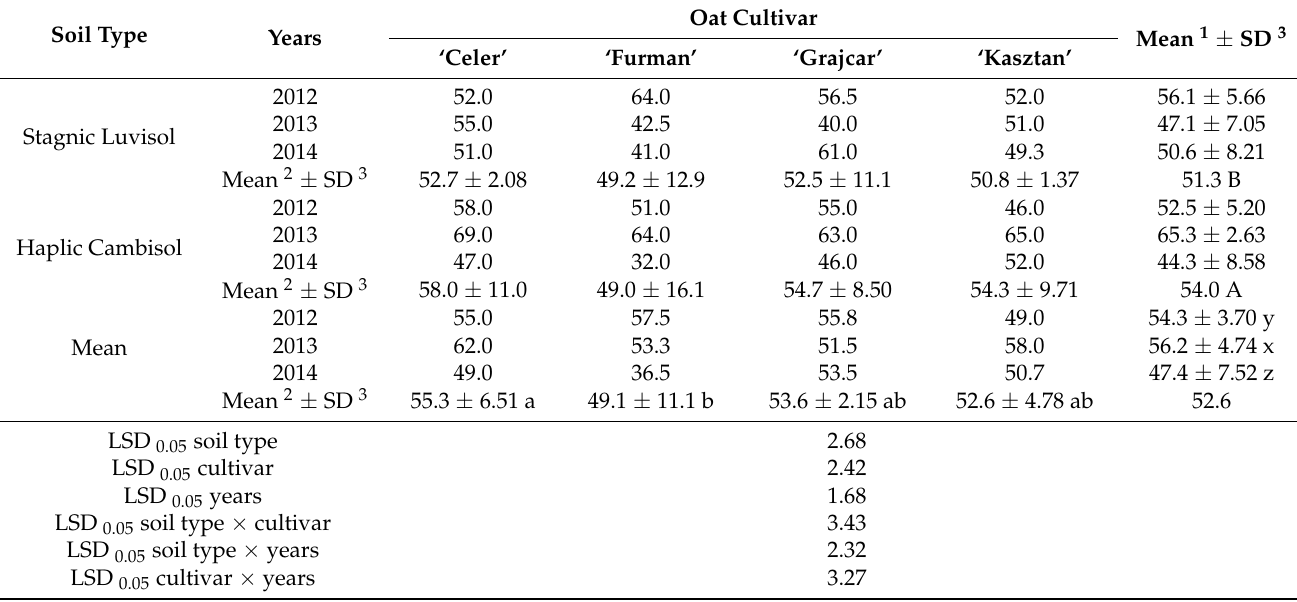
Table 6. Vetch density in spring (pieces m − 2 ) in mixture depending on the soil type (factor I), oat cultivar (factor II), and study years (factor